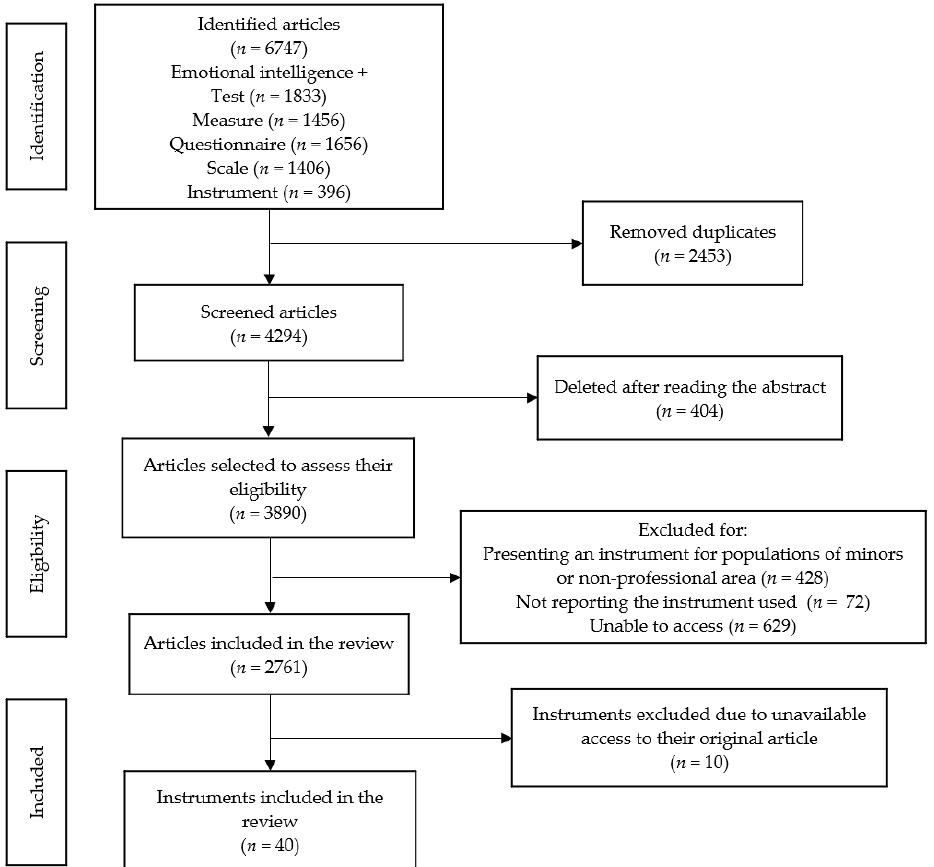
Figure 1. Flowchart according to PRISMA.